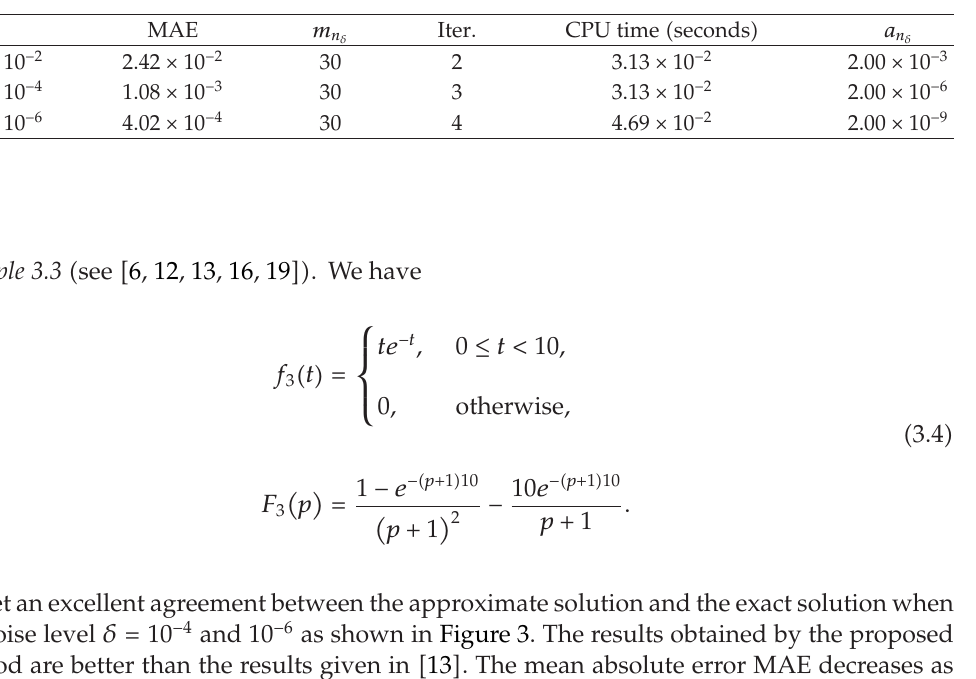
Table 3: Example